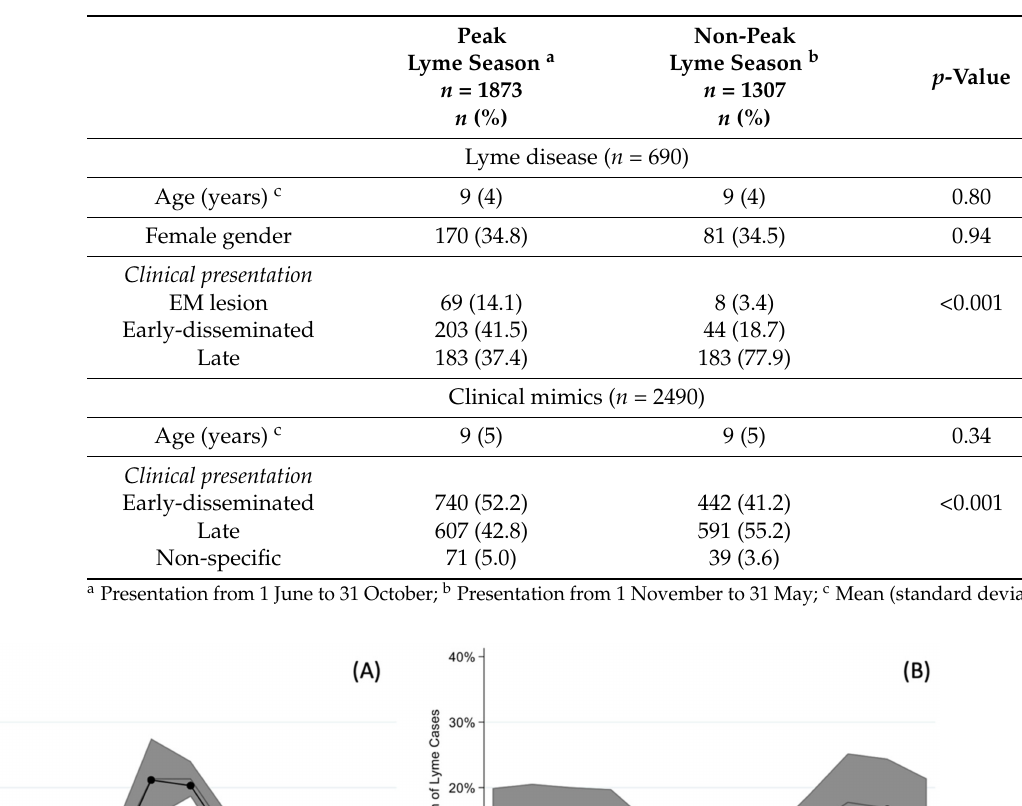
Table 2. Comparison of children with Lyme disease and clinical mimics who presented in the peak Lyme season versus the non-peak Lyme season.